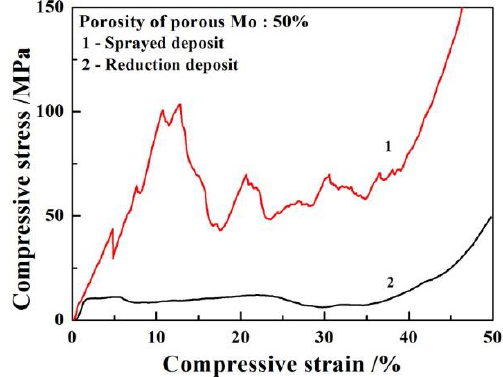
Figure 7. Compressive stress-strain curves of as-sprayed and reduced porous Mo deposits with 50% porosity.